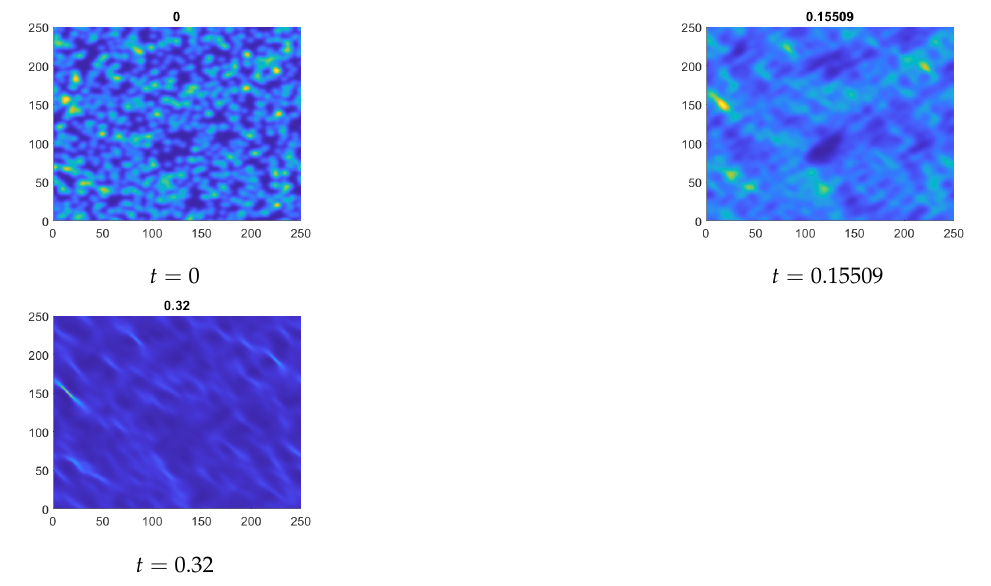
Figure 6. Anisotropic diffusion and anisotropic chemotaxis at different times. The cell density is 200 cells/mm 2